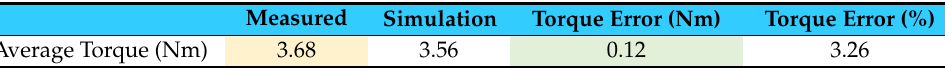
Table 4. The measured and simulated torque